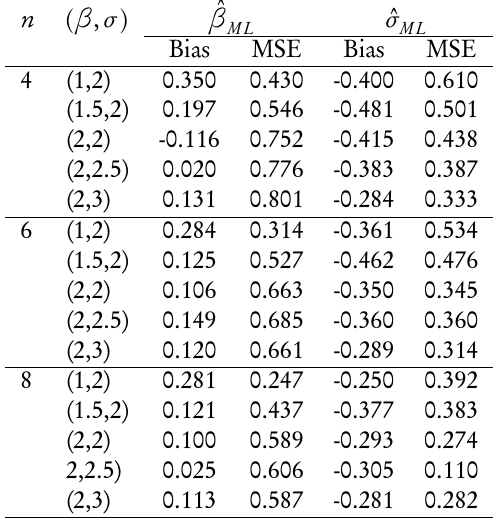
The bias and MSE of MLEs of β and σ for k = 2